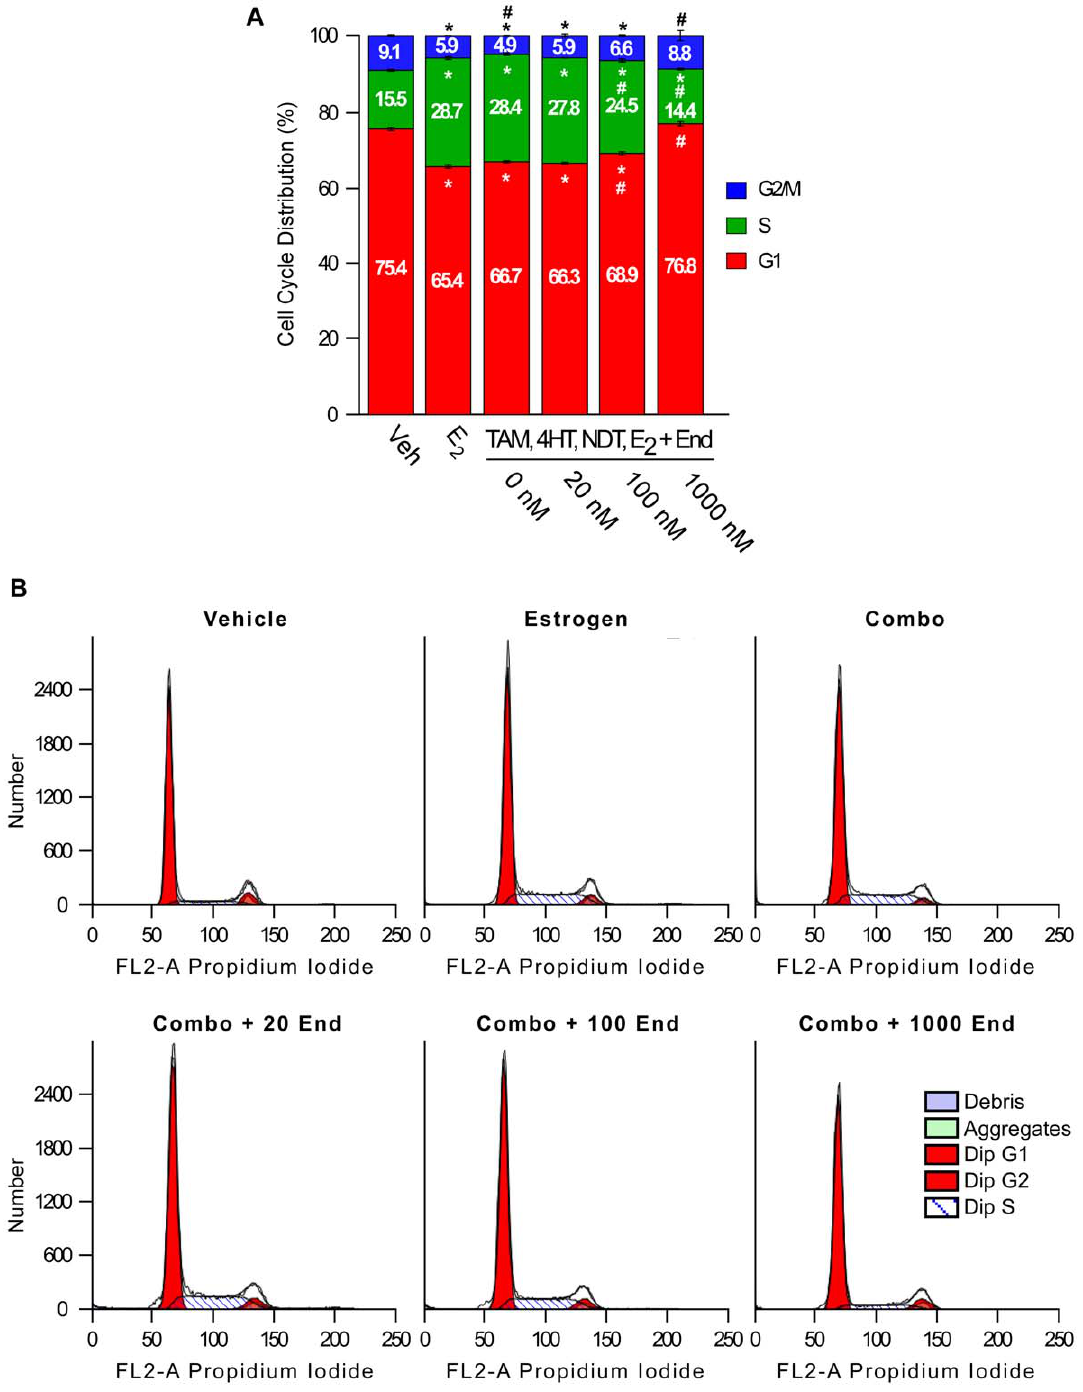
Figure 9. Profile of cell cycle changes induced by endoxifen. MCF7 cells were treated as indicated for 24 hours and cell cycle profiles were determined by propidium iodide staining and flow cytometry. ( A ) The percentage of cells from each treatment in G2/M phase (blue), S phase (green) and G1 phase (red) are shown. Asterisks within each cell cycle phase denote significance at the P , 0.05 level (ANOVA) compared to vehicle controls. # within each cell cycle phase denotes significant differences (P , 0.05) compared to estrogen treated cells. ( B ) Representative flow cytometry plots for each treatment condition.